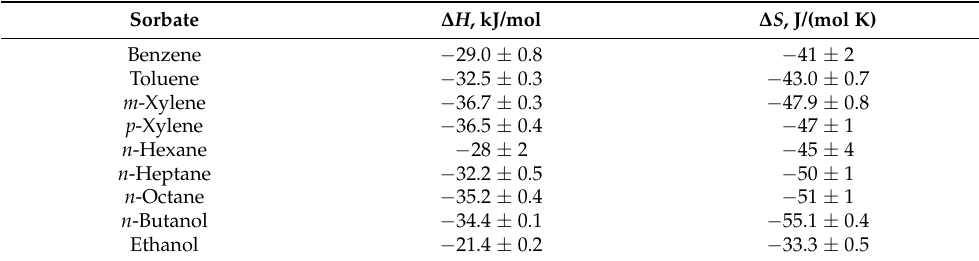
Table 1. Thermodynamic parameters of sorption of hydrocarbons and alcohols in PTBSN in the initial state.